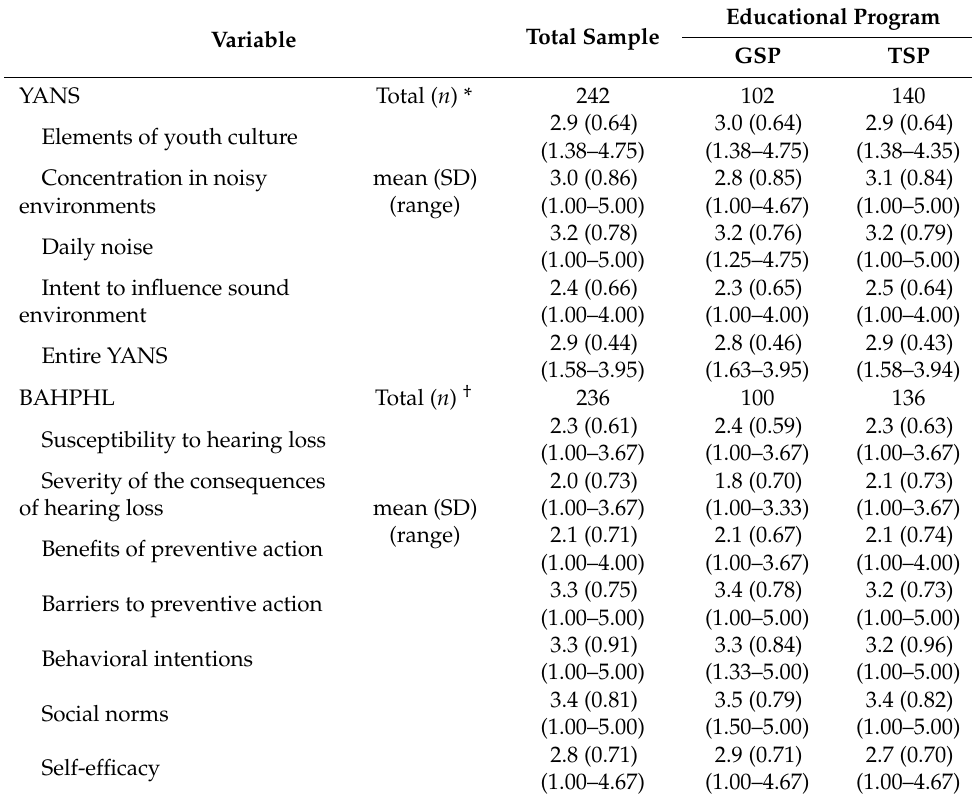
Table 4. Description of the attitudes and beliefs towards noise, hearing loss, and HPDs for the total sample as well as distributed for the students from the GSP and